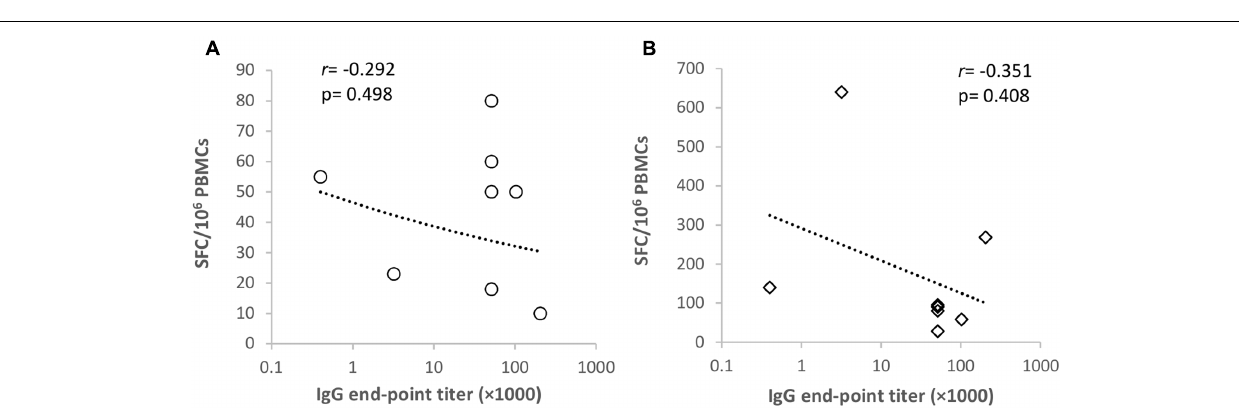
FIGURE 4 | Correlation of GII.4-1999-specific antibody and T cell responses. Spearman’s rank correlation ( r ) was determined between the norovirus GII.4-1999-specific antibody titer and ELISPOT IFN- γ spot-forming cell (SFC)/10 6 peripheral blood mononuclear cells (PMBCs) in response to GII.4-99 VLPs (A) and a complete capsid peptide pool (B)